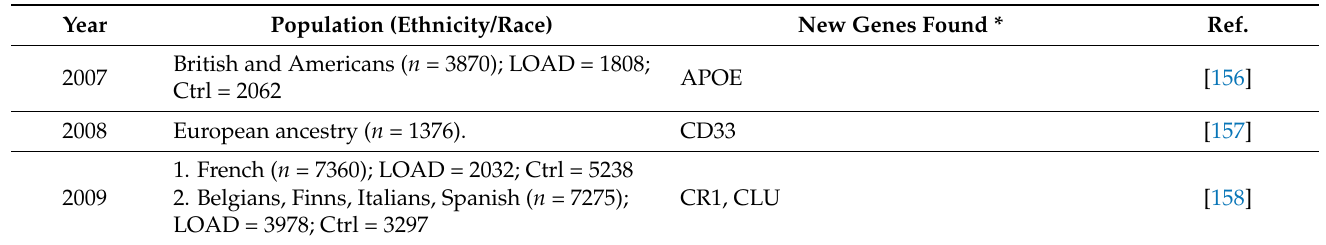
Table 2. Genome-wide association studies (GWAS) for Alzheimer’s